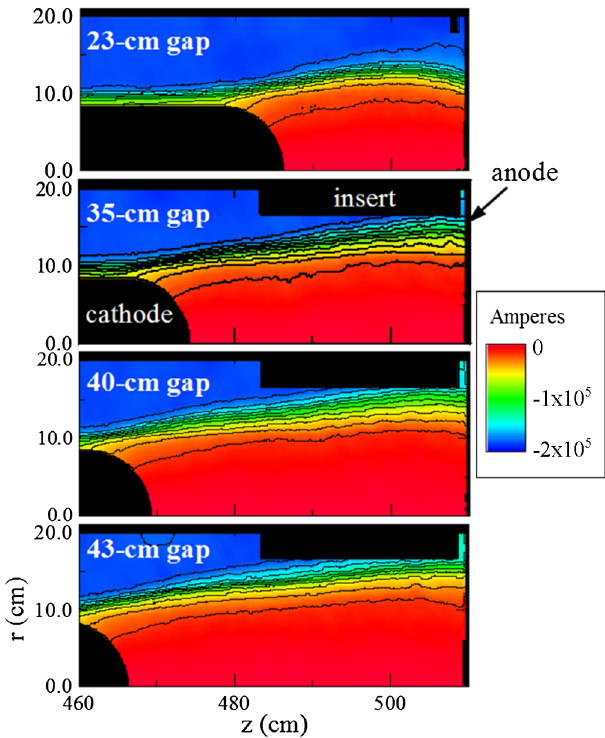
FIG. 4. LSP rB θ distributions (current enclosed within radius r ) in the diode forvarious diodegaps at the time ofpeak diodevoltage (50nsinFig.3a).Overlaid arecurrent contoursin10%increments.